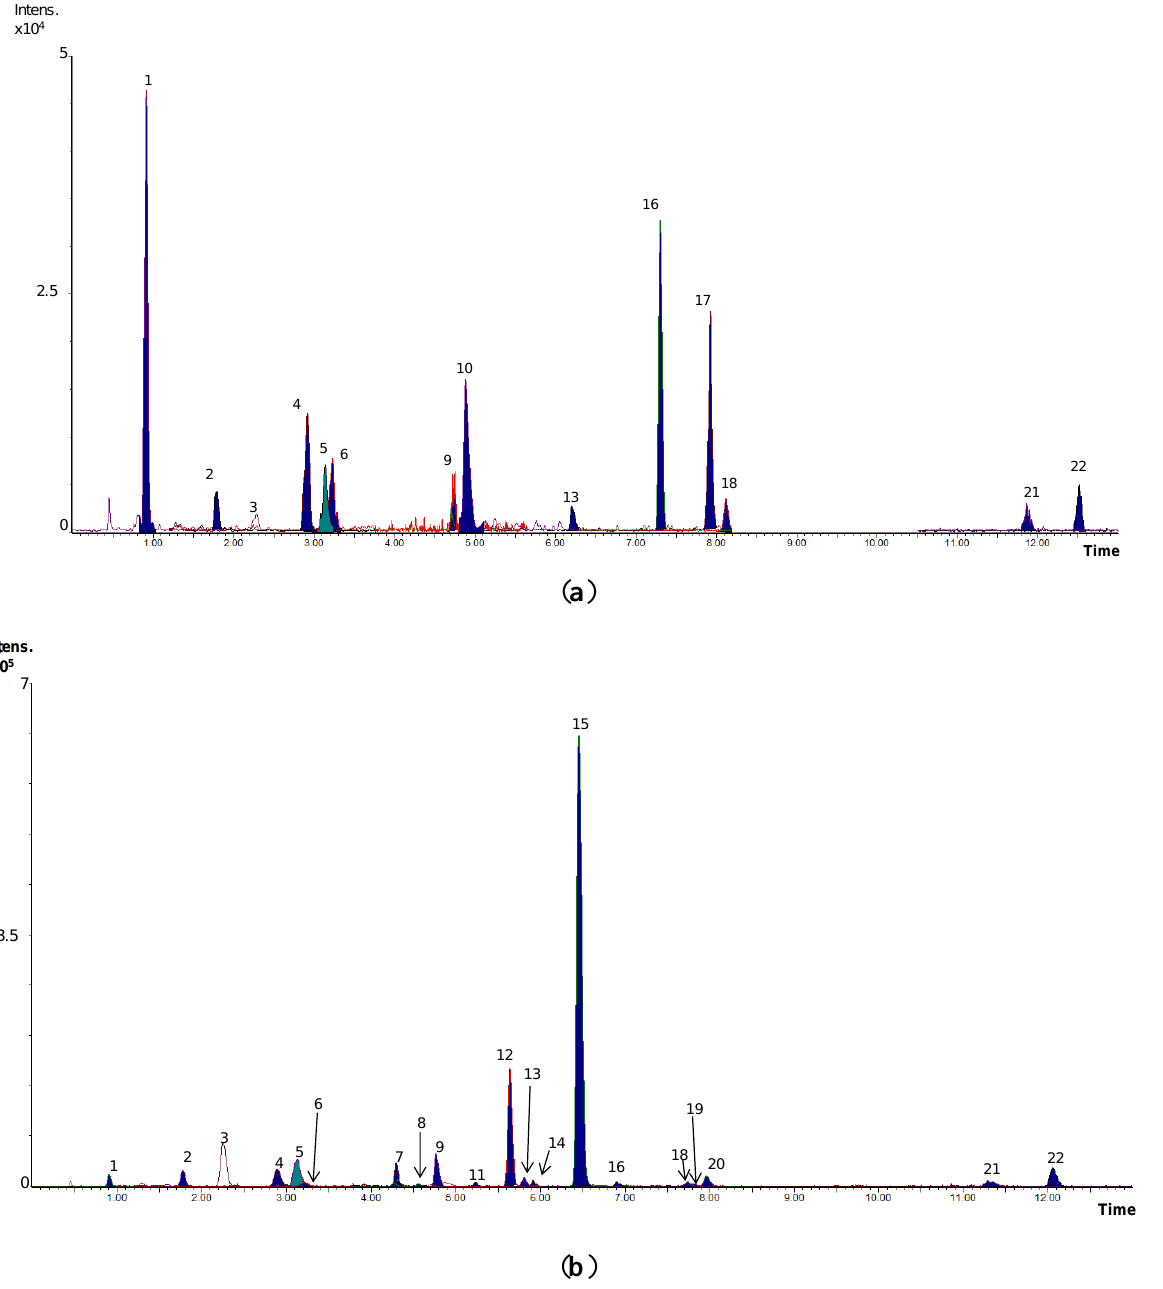
Figure 1. Overlapped MRM chromatograms before ( a ) and after ( b ) wine intake